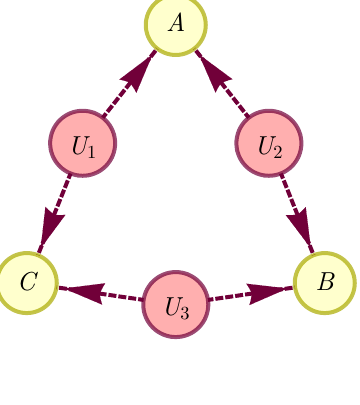
Figure 3: The triangle scenario.